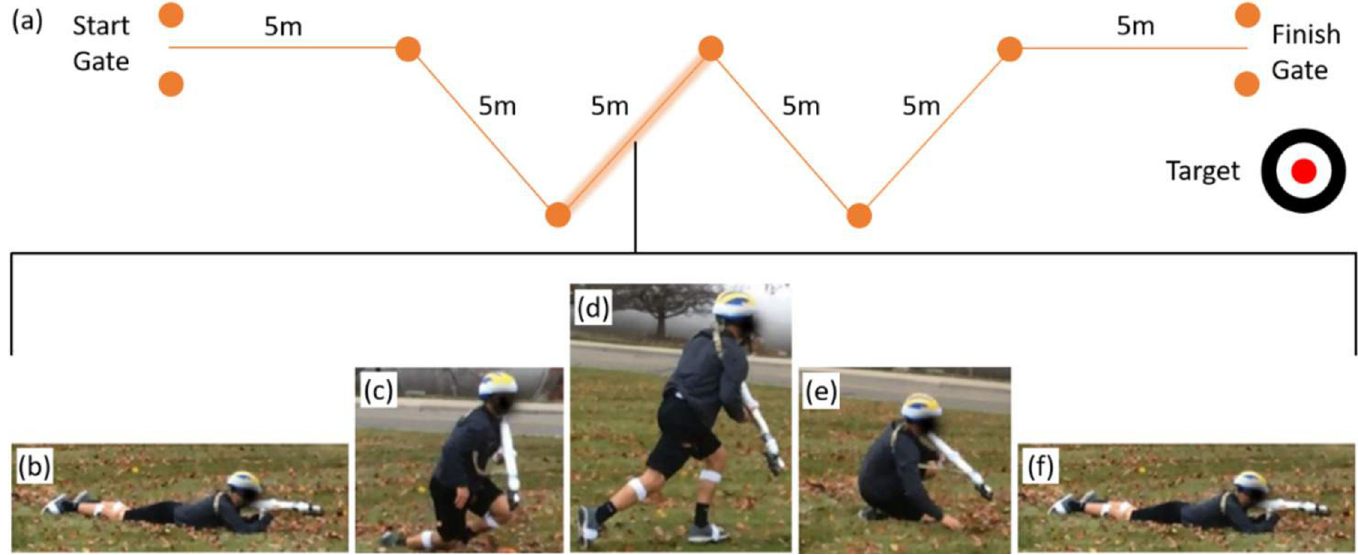
Fig 14. Bounding rush obstacle. a) The layout for the bounding rush obstacle and an example of a participant aiming and then executing a single bounding rush (b)-(f). The photos illustrate the aiming phases (b) and (f) that bookend each bounding rush that consists of: c) standing quickly, d) sprinting to the next cone, and e) dropping quickly to